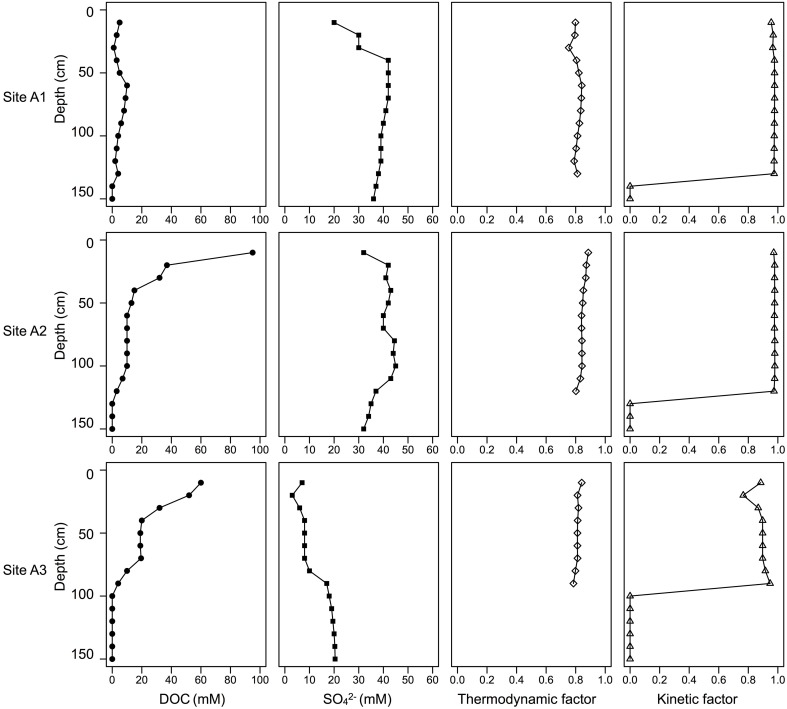
Depth profile of DOC, SO2−4, labile Fe(III), crystalline Fe(III), soil density, and kinetic drives of heterotrophic sulfate and iron reductions. The values of DOC, SO2−4, labile Fe(III), crystalline Fe(III), and soil density are modified from Burton et al. (2011).